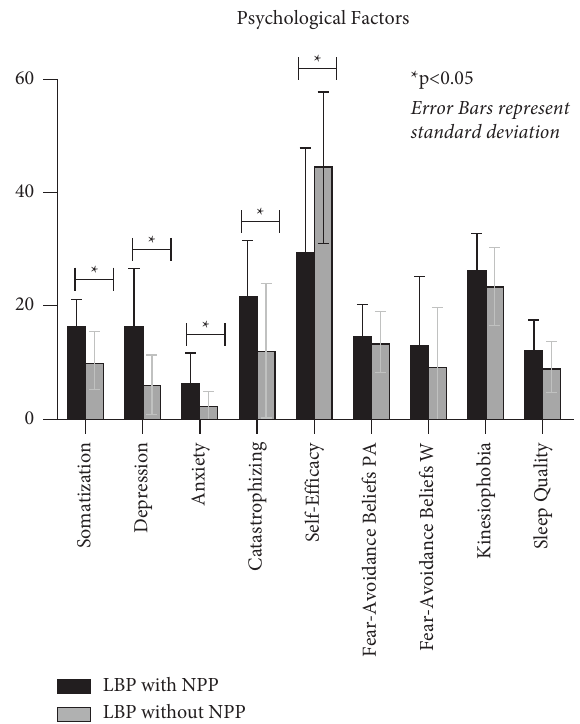
Figure 1: Pain-related psychological factors by